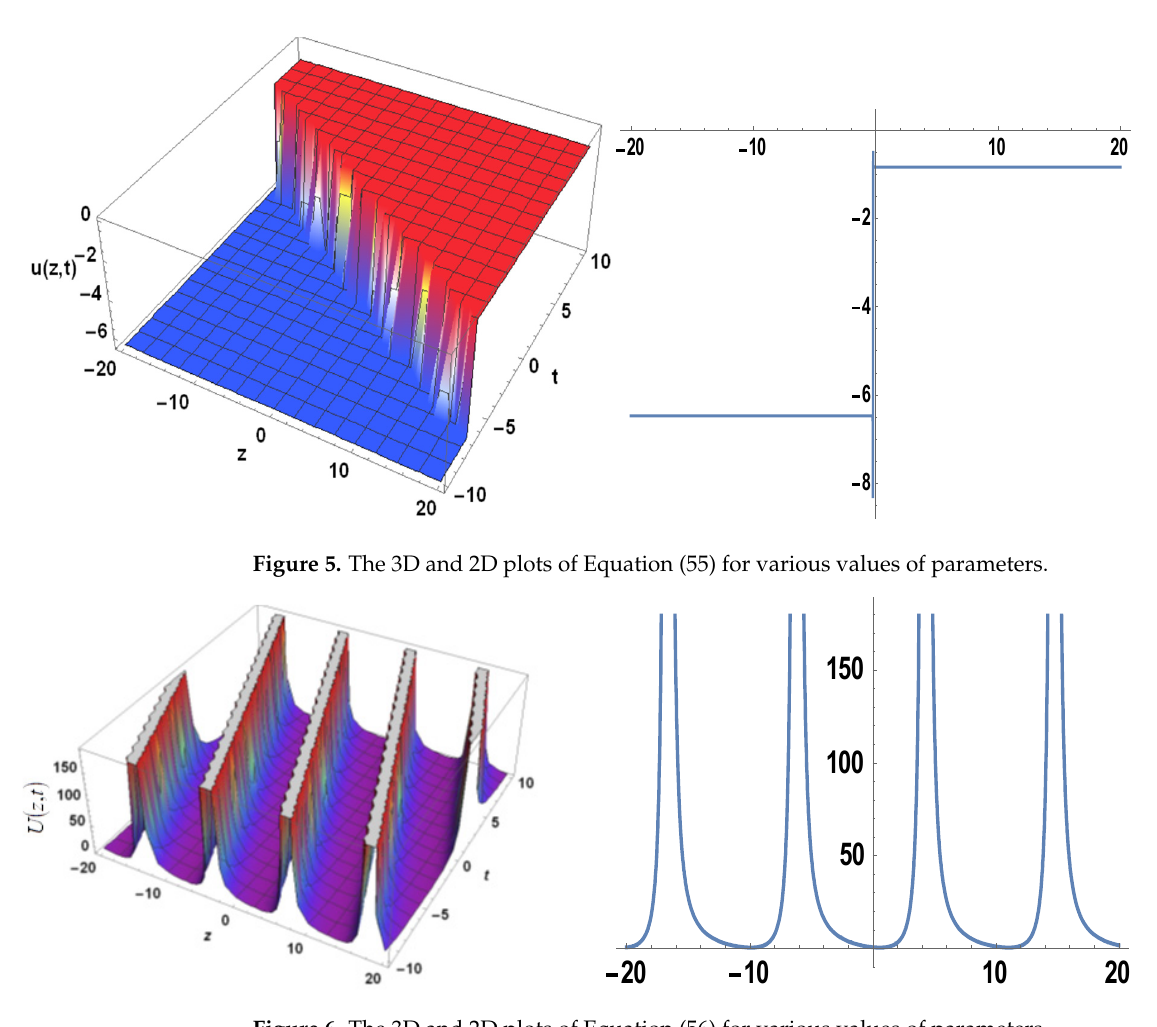
Figure 4. The 3D and 2D plots of Equation (54) for various values of parameters.